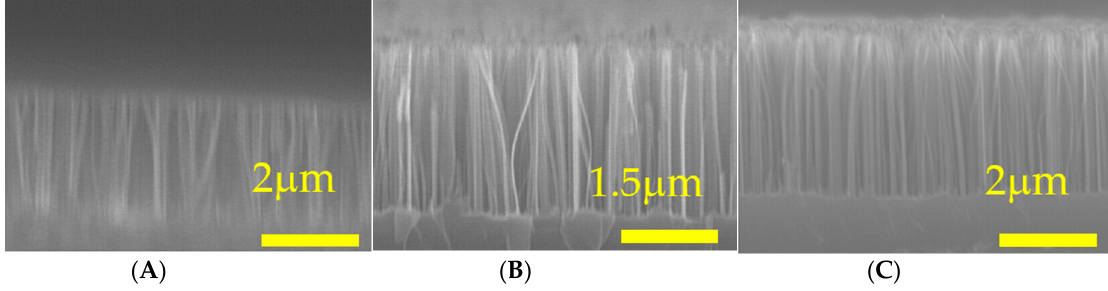
Figure 4. Cross-sectional SEM images of SiNWs fabricated via metal-assisted chemical etching with different concentrations of AgNO 3 : ( A ) 0.01 M, ( B ) 0.015M, and ( C ) 0.02